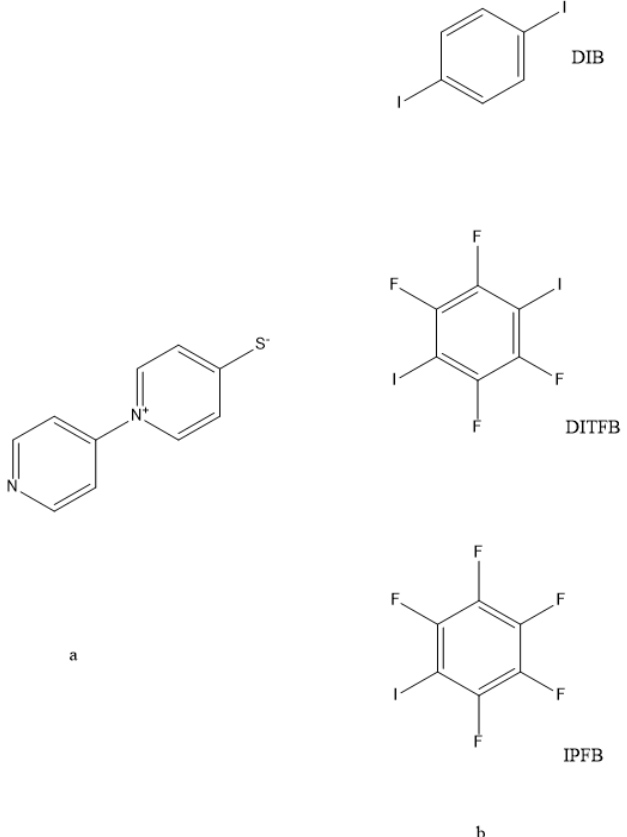
Figure 1. Schematic structure of XB acceptor and donors. ( a ) The schematic structure of PTP; ( b ) the schematic structure of 1,4-diiodobenzene (DIB), of 1,4-diiodotetrafluorobenzene (DITFB), and of iodopentafluorobenzene (IPFB).